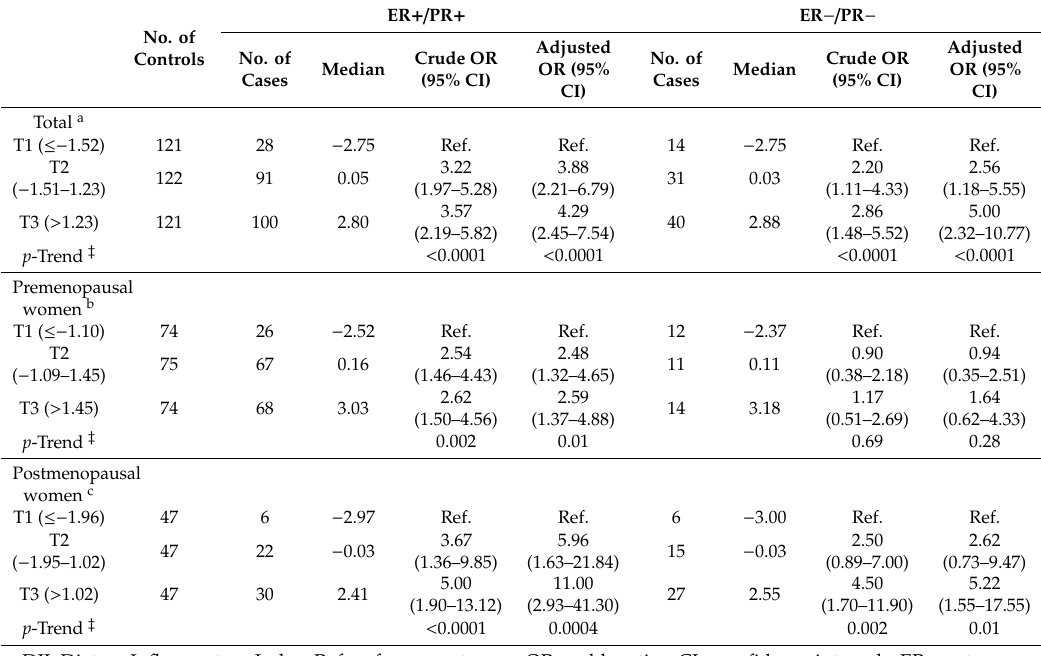
Table 4. Odds ratios (95% CIs) of breast cancer characterized by hormone receptor status according to DII